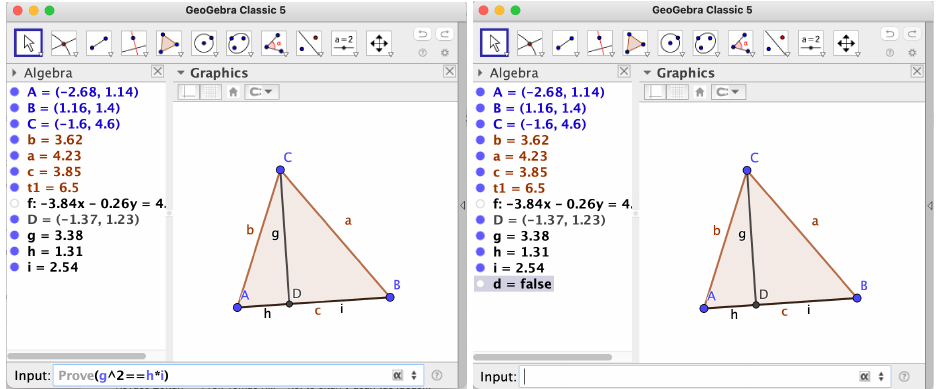
Figure 1. Left, GeoGebra is asked about the validity of the Altitude Theorem over an arbitrary triangle. Right, it declares it is